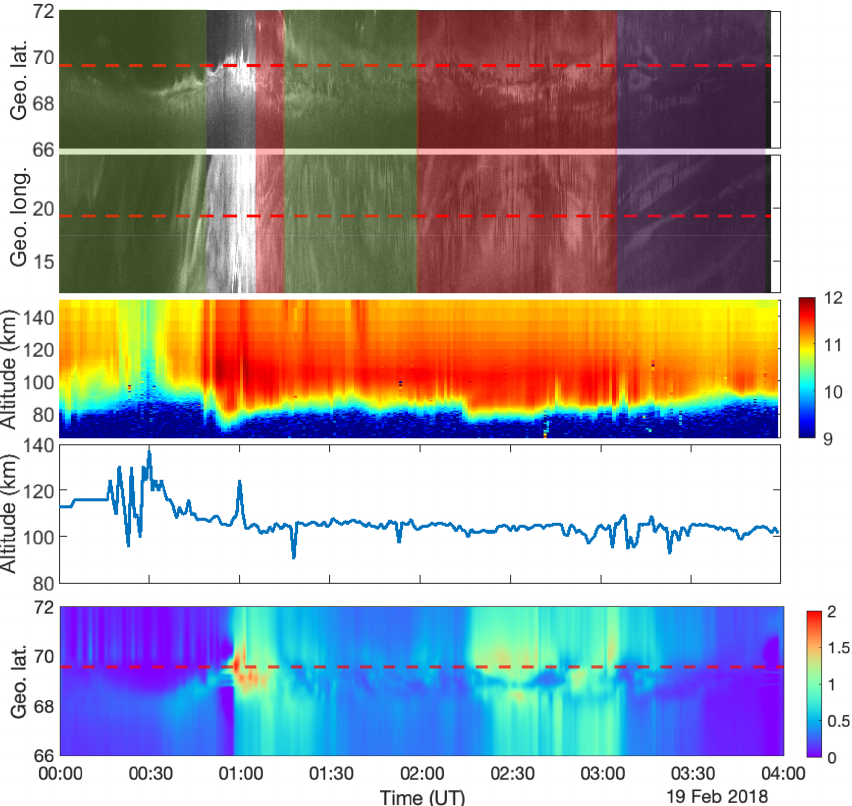
Figure 4. Similar to Figs. 2 and 3 but on 19 February 2018 with an additional panel of KAIRA CNA riogram (in dB). The dashed red line overlaid in the riogram is the EISCAT